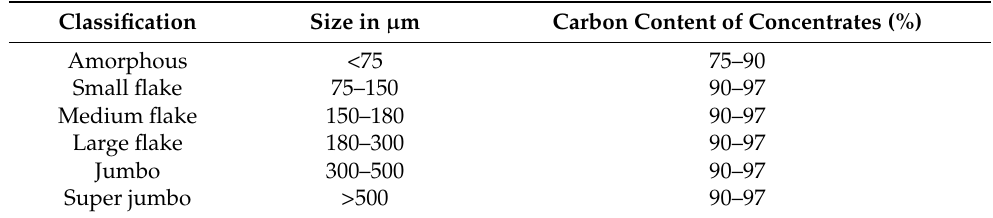
Table 1. Market terminology of natural graphite and general properties (modified after